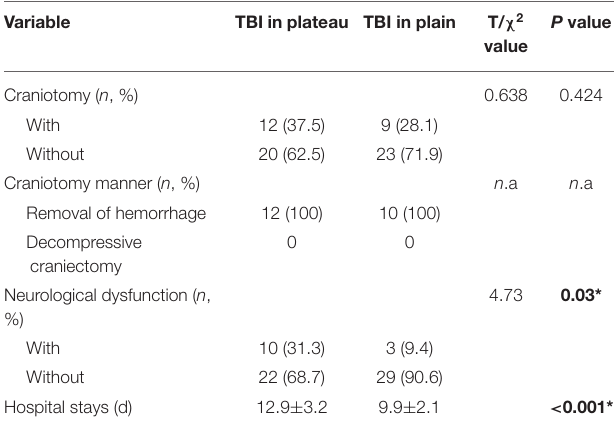
TABLE 8 | Treatment and outcome in patients with TBI at the plateau and plain areas.